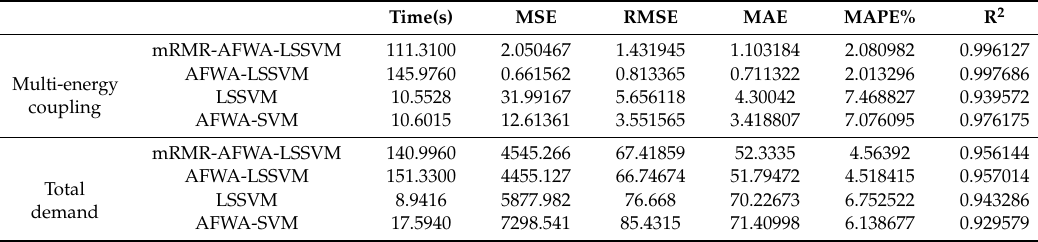
Table 9. Model comparison and